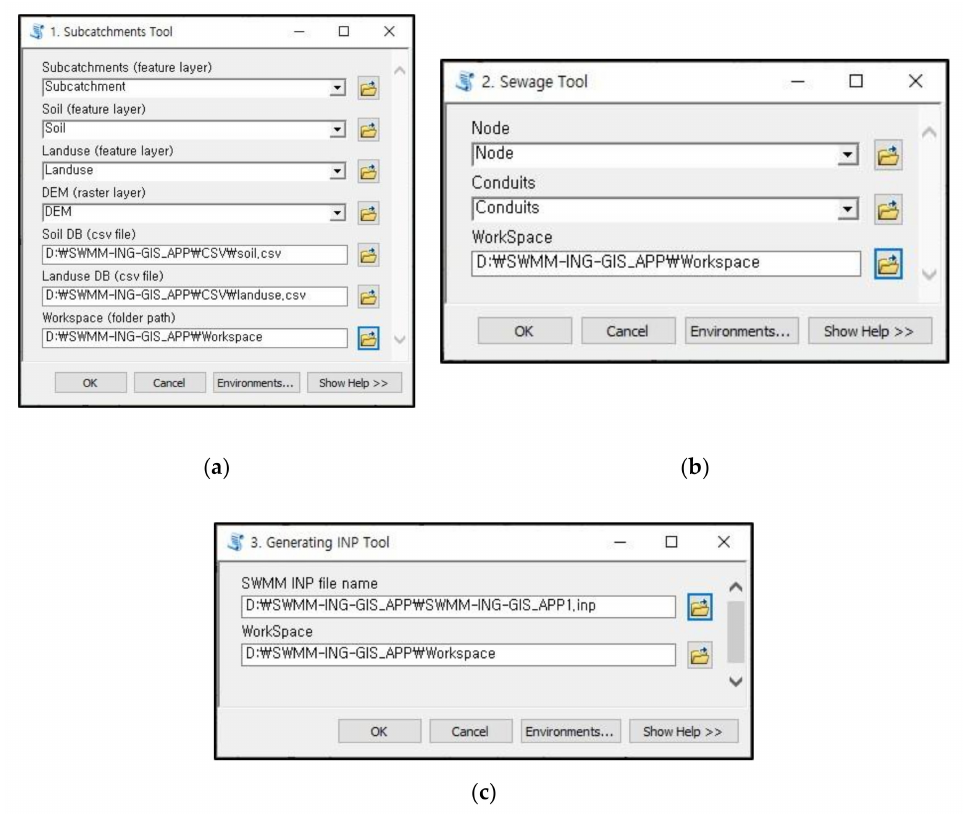
Figure 5. Interface of ArcGIS-based tools developed in the study to prepare SWMM inputs: